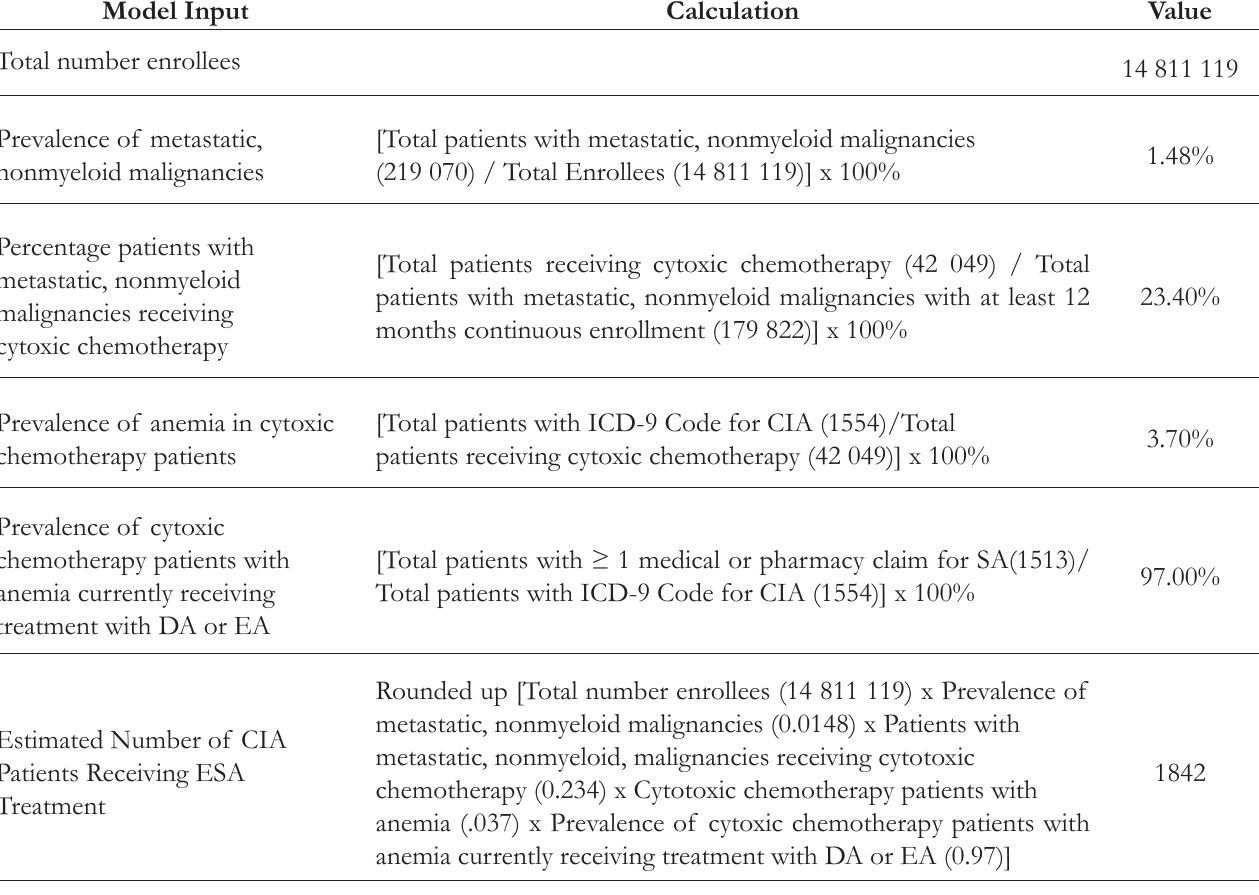
Table 1. Inputs to Calculations on Estimated Number of CIA Patients Receiving ESA